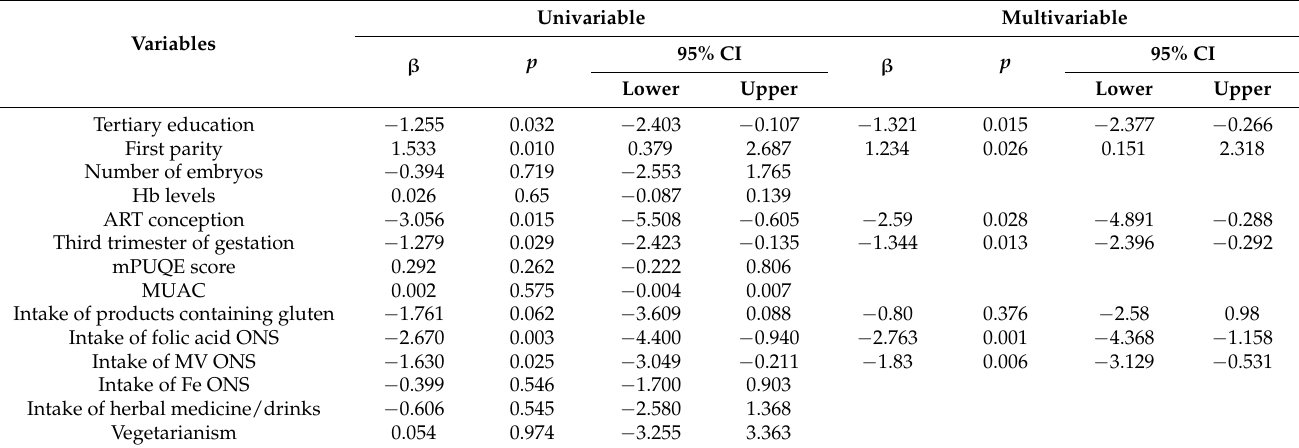
Table 3. Univariable and multivariable logistic regression models explaining